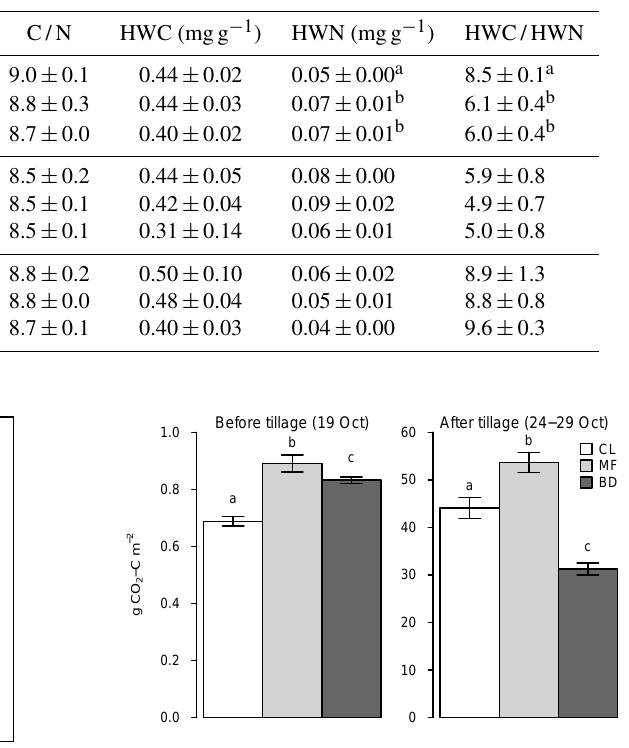
Figure 3. Cumulated soil CO 2 effluxes on a day before (19 October, between 07:00 and 13:00LT) and the period (24 October, 07:00LT– 29 October, 13:00LT) tillage. Different letters indicate significant differences (Tukey’s HSD test, p < 0.05) in means of the cumulated fluxes of the treatments (CL, control; MF, mineral fertiliser; BD, biogas digestate) before and after. Error bars represent the standard deviation of interpolation by bootstrapping after 250 iteration